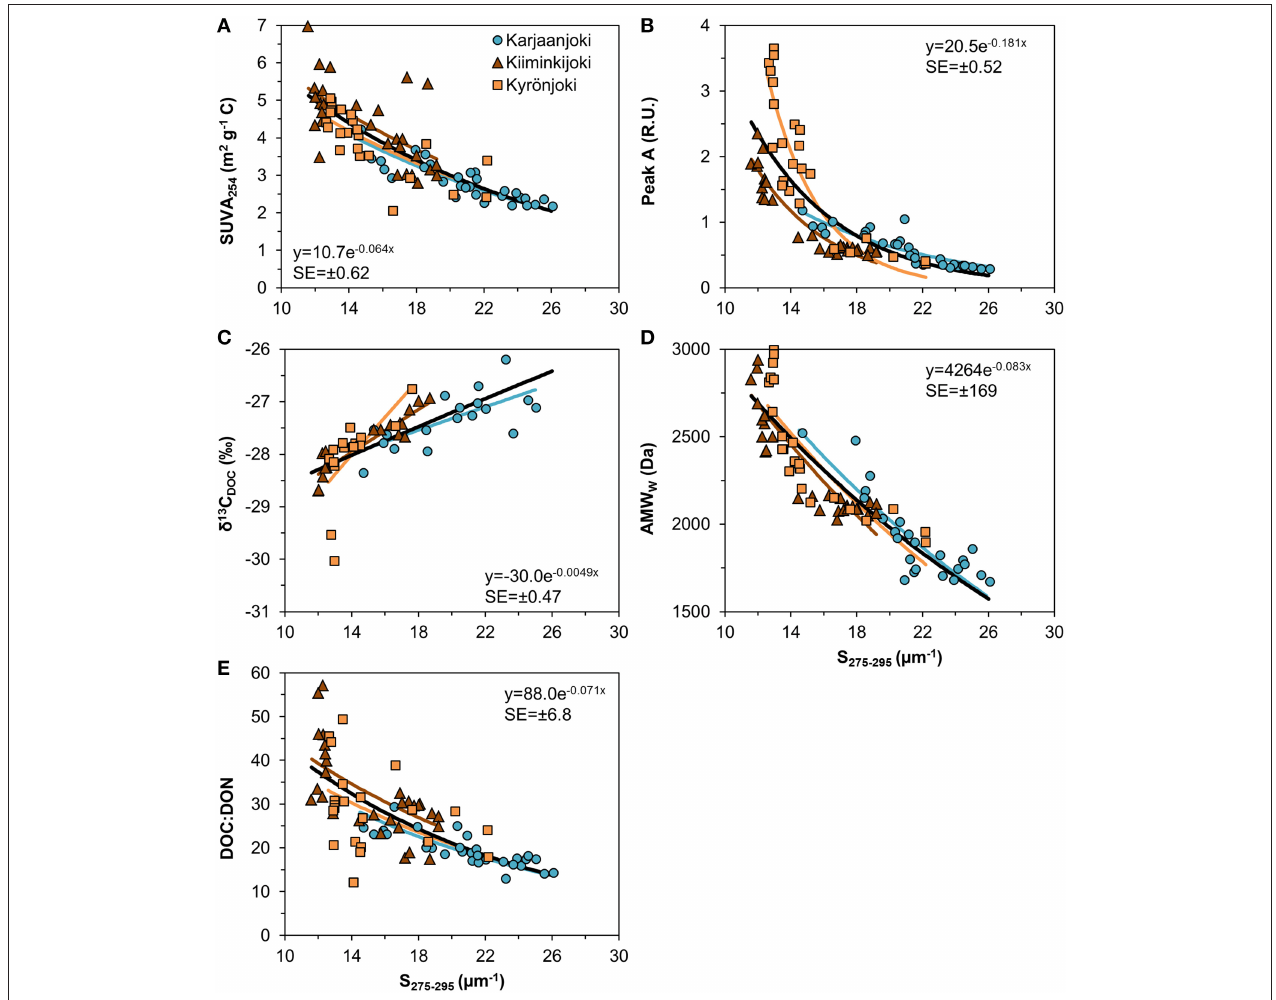
FIGURE 7 | Relationship between UV slope (S 275 − 295 ) and other DOM quality variables used in this study. (A) SUVA 254 ; (B) Fluorescence peak A; (C) 13 δ C DOC ; (D) AMW W ; (E) DOC:DON ratio. Exponential models were fitted to data for each estuary after testing for common intercepts and exponential slopes. A common model (black line) was fitted to all data with the formula and the residual standard error (SE) inserted in the